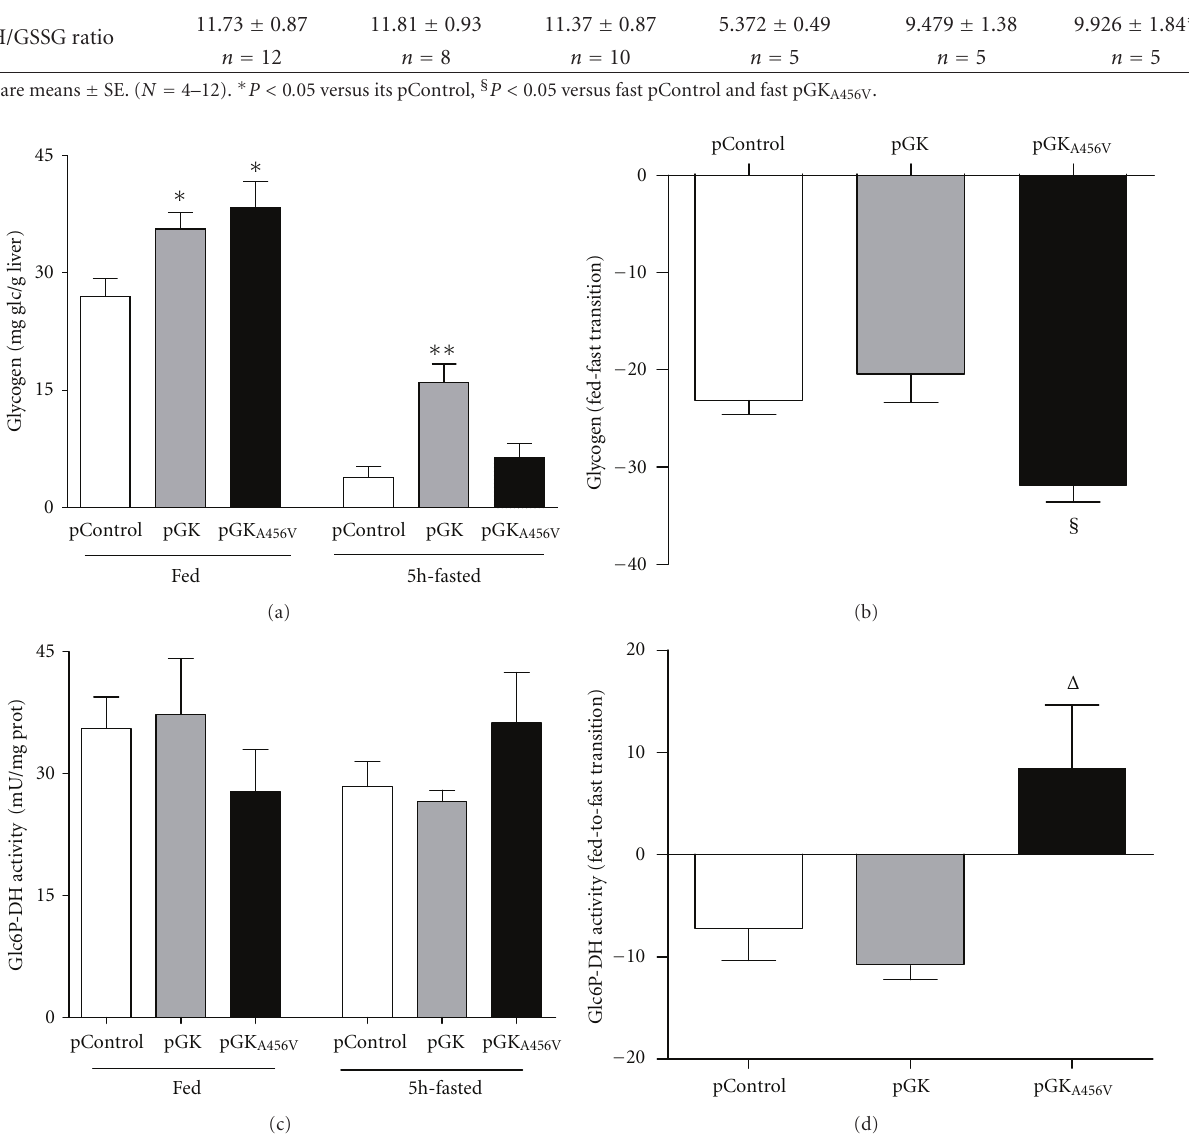
Figure 4: E ff ects of GK and GK A456V overexpression on glycogen and glucose-6-phosphate DH activity in the liver. (a) Glycogen levels from fed and 5-hour fasted mice. (b) Glycogen balance between the fast and fed transition. (c) Glc6P DH activity was measured in liver extracts of mice in fed and fasted state. (d) Variation of Glc6P DH activity during the fed-to-fast transition. Data are mean ± SE. ( N = 5–9. ∗ P < 0 . 05 versus pControl; § P < 0 . 05 versus pControl and P < 0 . 01 versus pGK; Δ P < 0 . 05 versus pControl and